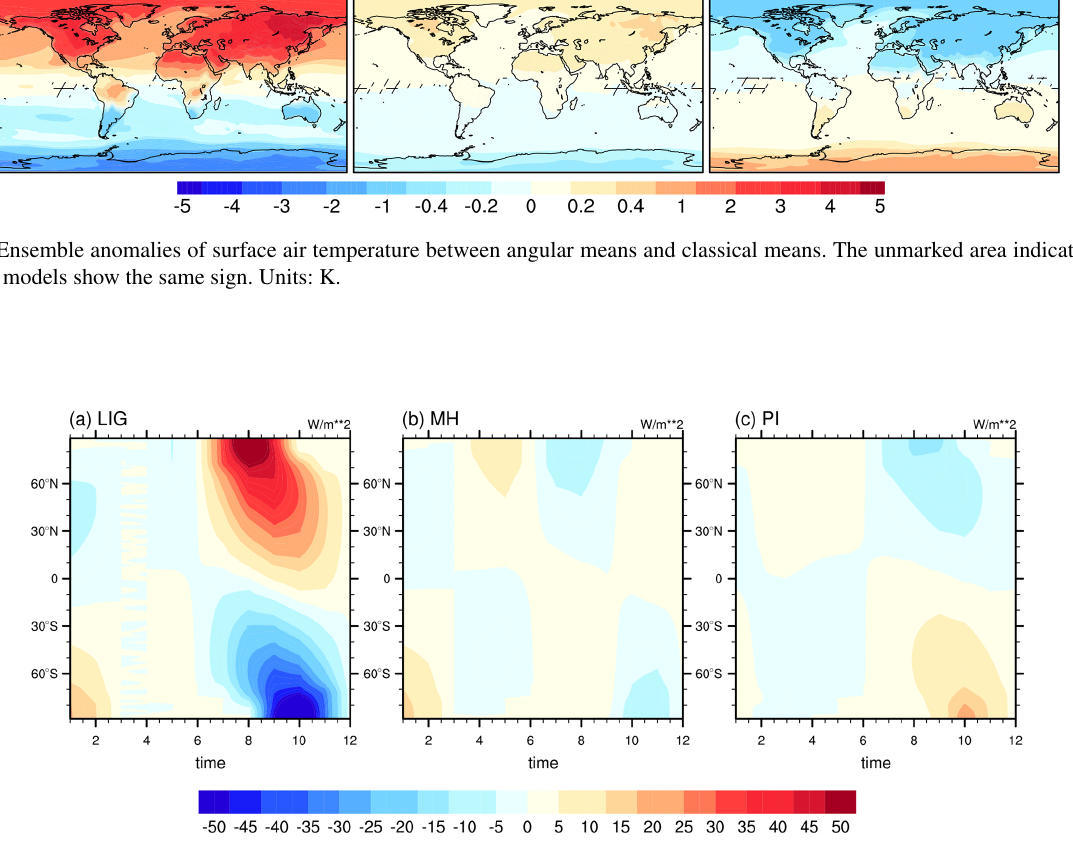
https://doi.org/10.5194/cp-18-1047-2022 Clim. Past, 18, 1047–1070,